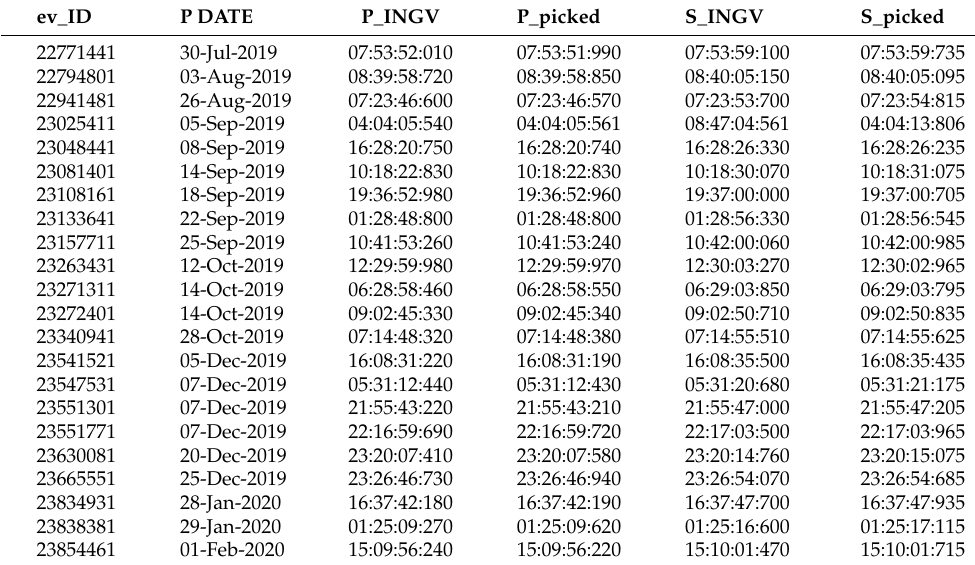
Table 2. Comparison between p and s onset picking, INGV seismic bulletin values compared to our